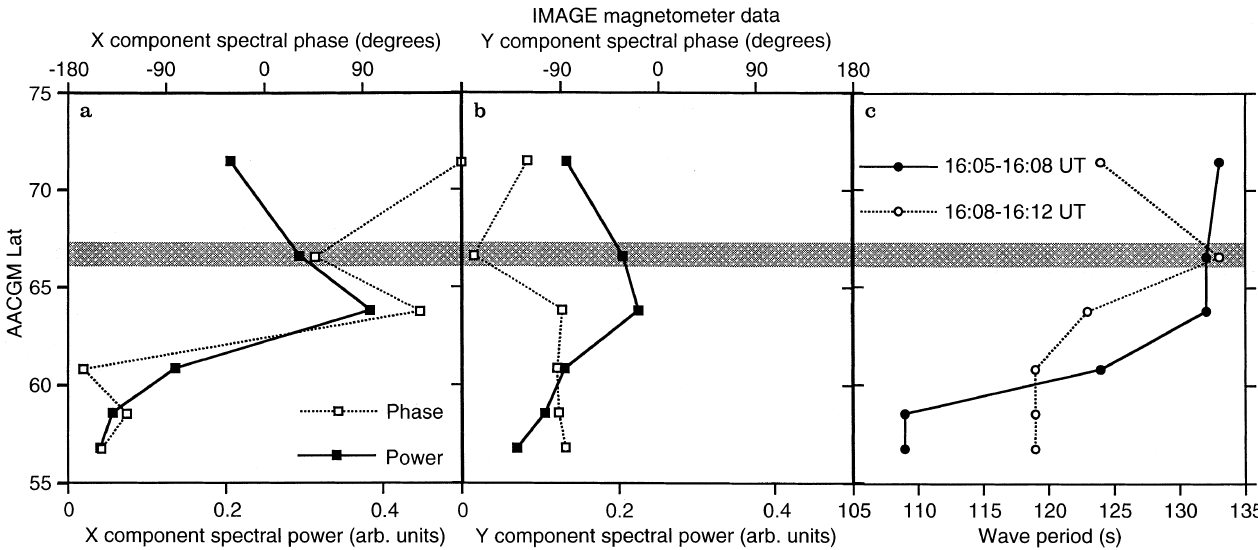
Fig. 6 a–c. Wave parameters derived from the magnetometer data presented in Fig. 3. Fourier spectral amplitude and phase at 7.9 mHz are presented for a the X component and b the Y component.